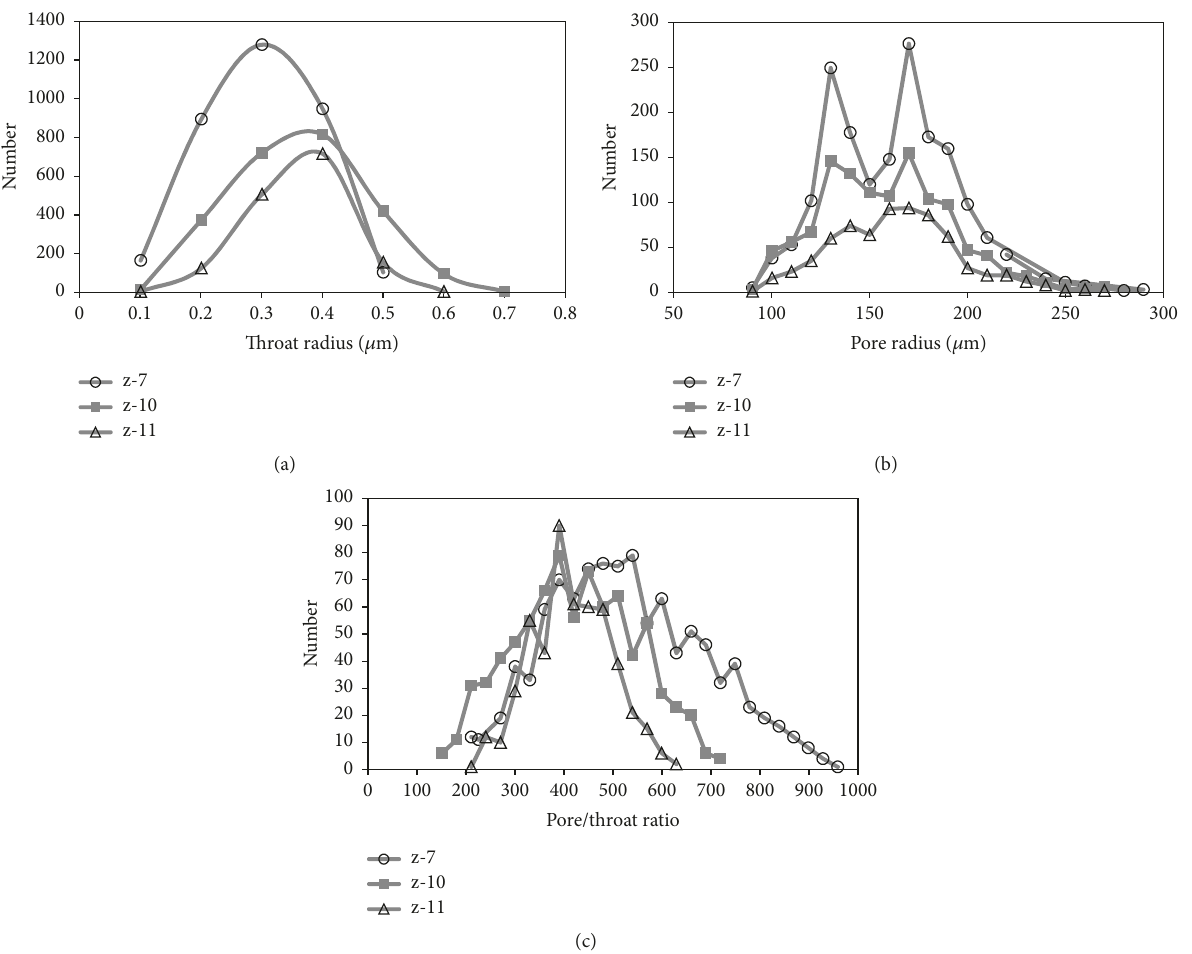
Figure 5: The example of the distributional characteristics of throat (a), pore (b) radius, and pore/throat ratio (c) in the tight clastic rock samples from Upper Triassic Chang 7 Member, Odors